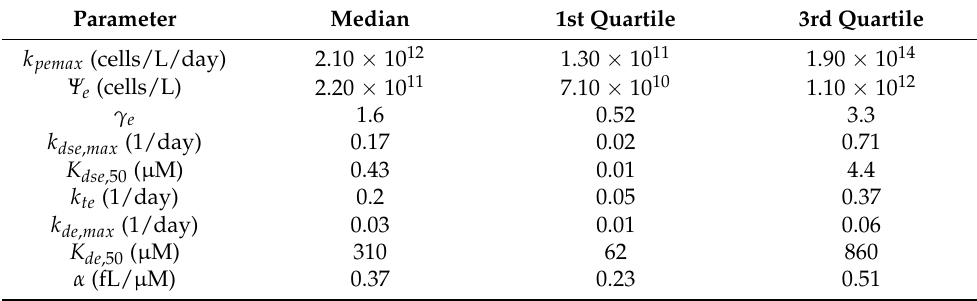
Table 3. RBC and MCV model parameter estimates for HUSTLE participants.